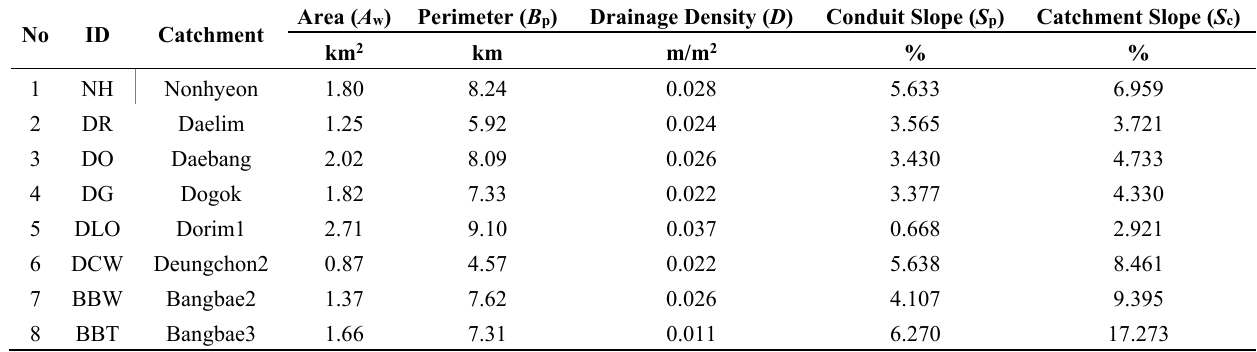
Table 1. Test catchments selected for